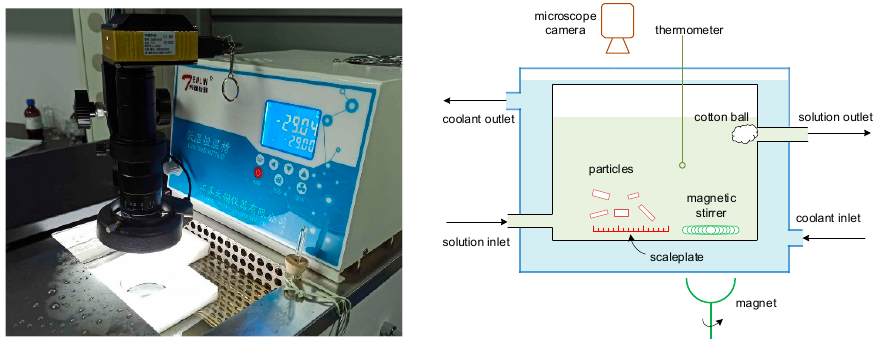
Figure 3. The experimental setup and schematic representation for determining the kinetics of nucleation, growth, breakage, and aggregation.